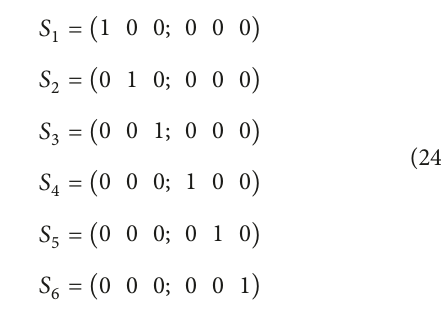
Figure 2: Three robots transporting triangular goods in